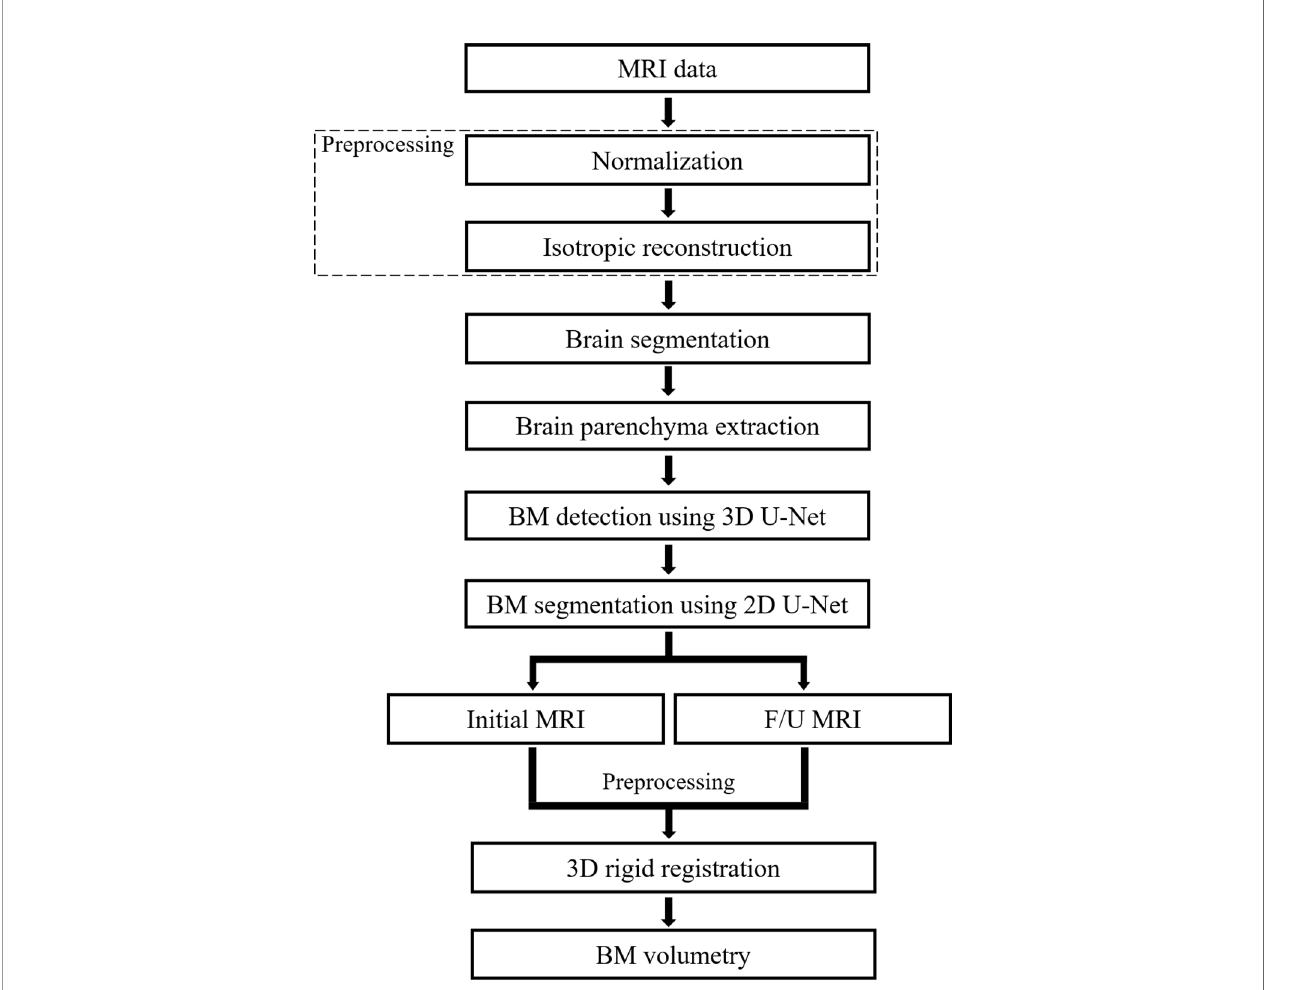
FIGURE 1 | Flowchart of the proposed deep learning-based computer-aided detection system. F/U, follow-up; BM, brain